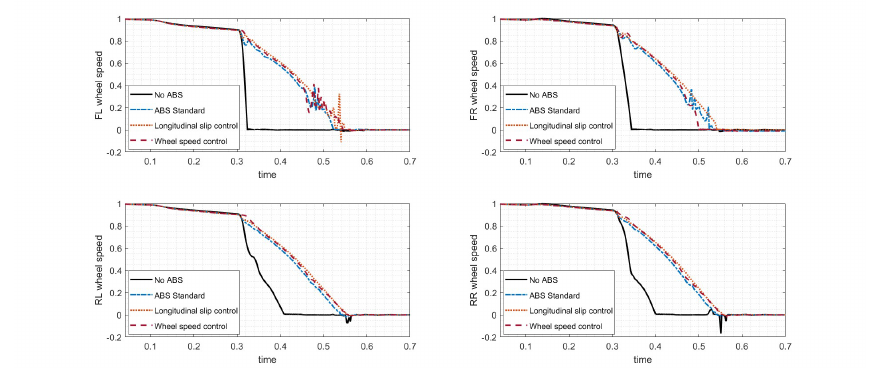
Figure 10. Wheel angular speed in combined braking from 80 to 0 km/h at lateral acceleration of 0.9 g with and without ABS